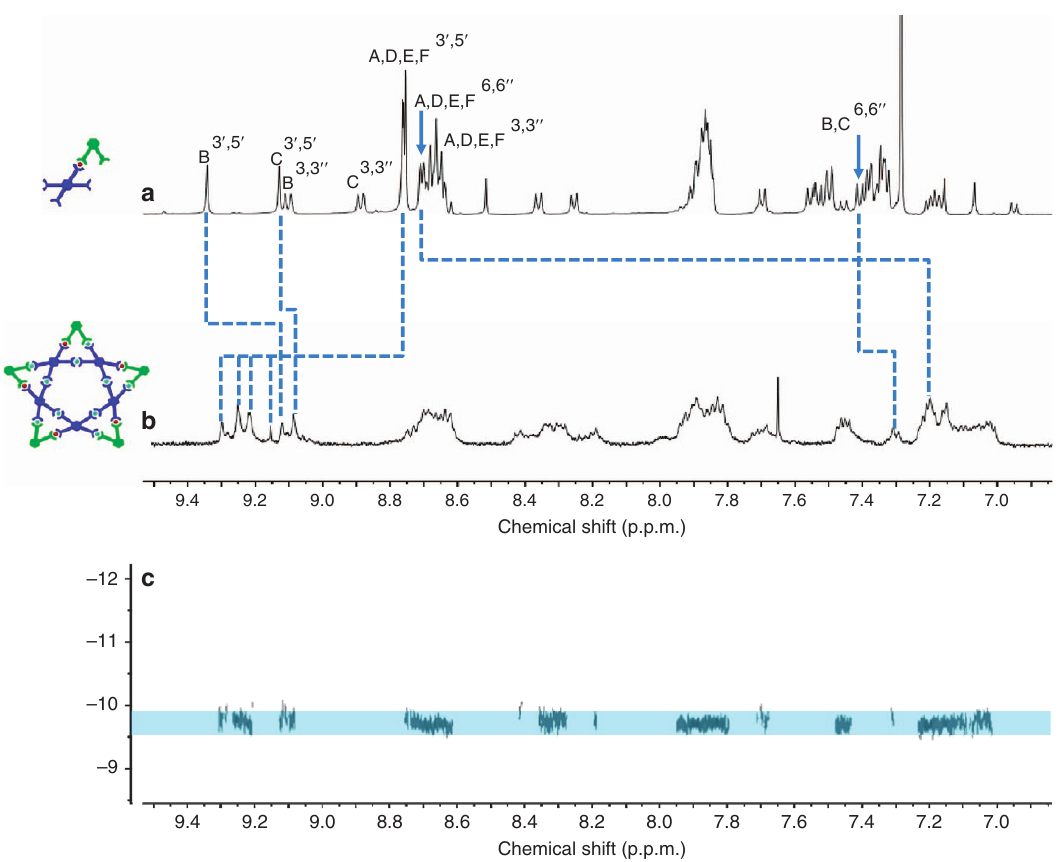
Figure 4 | 1 H NMR spectrum. ( a ) LA and ( b ) molecular pentagram [Fe 10 LA 5 )] ; ( c ) DOSYof [Fe 10 LA 5 )] (500MHz, 25 (cid:2) C, CDCl 3 for ligands and CD 3 CN for